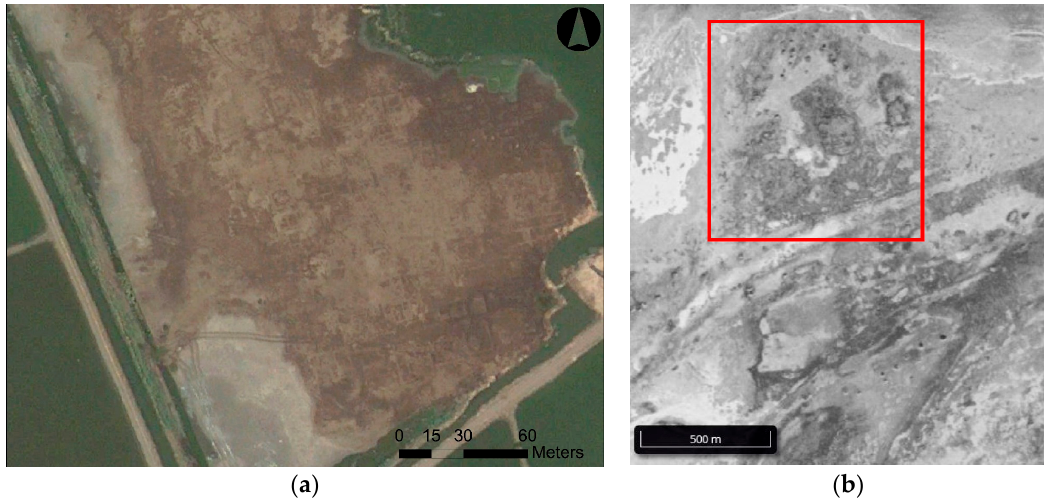
Figure 21. ( a ) The site of Tell er-Ruhban. Image courtesy Google Earth; ( b ) 1968 CORONA image. The area of image ( a ) is in the red box. Image courtesy of the Center for Advanced Spatial Technologies, University of Arkansas/U.S. Geological Survey.